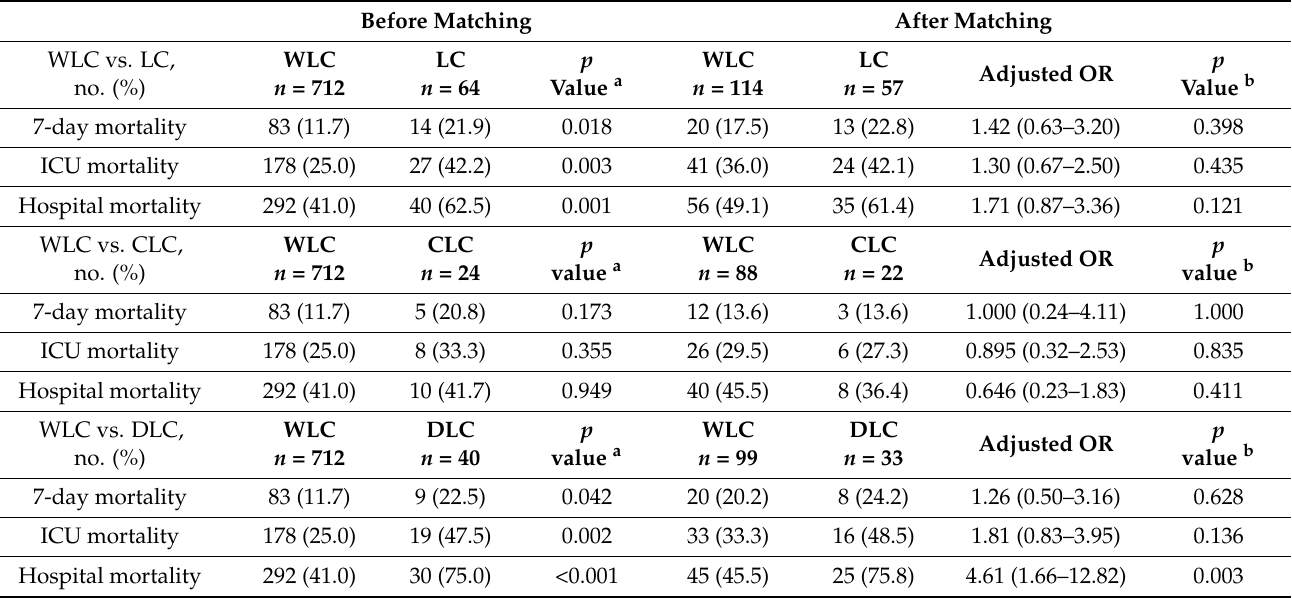
Table 5. Mortalities were analyzed in the without liver cirrhosis group vs. the liver cirrhosis and without liver cirrhosis groups vs. the decompensated liver cirrhosis group before and after matching. Before Matching After